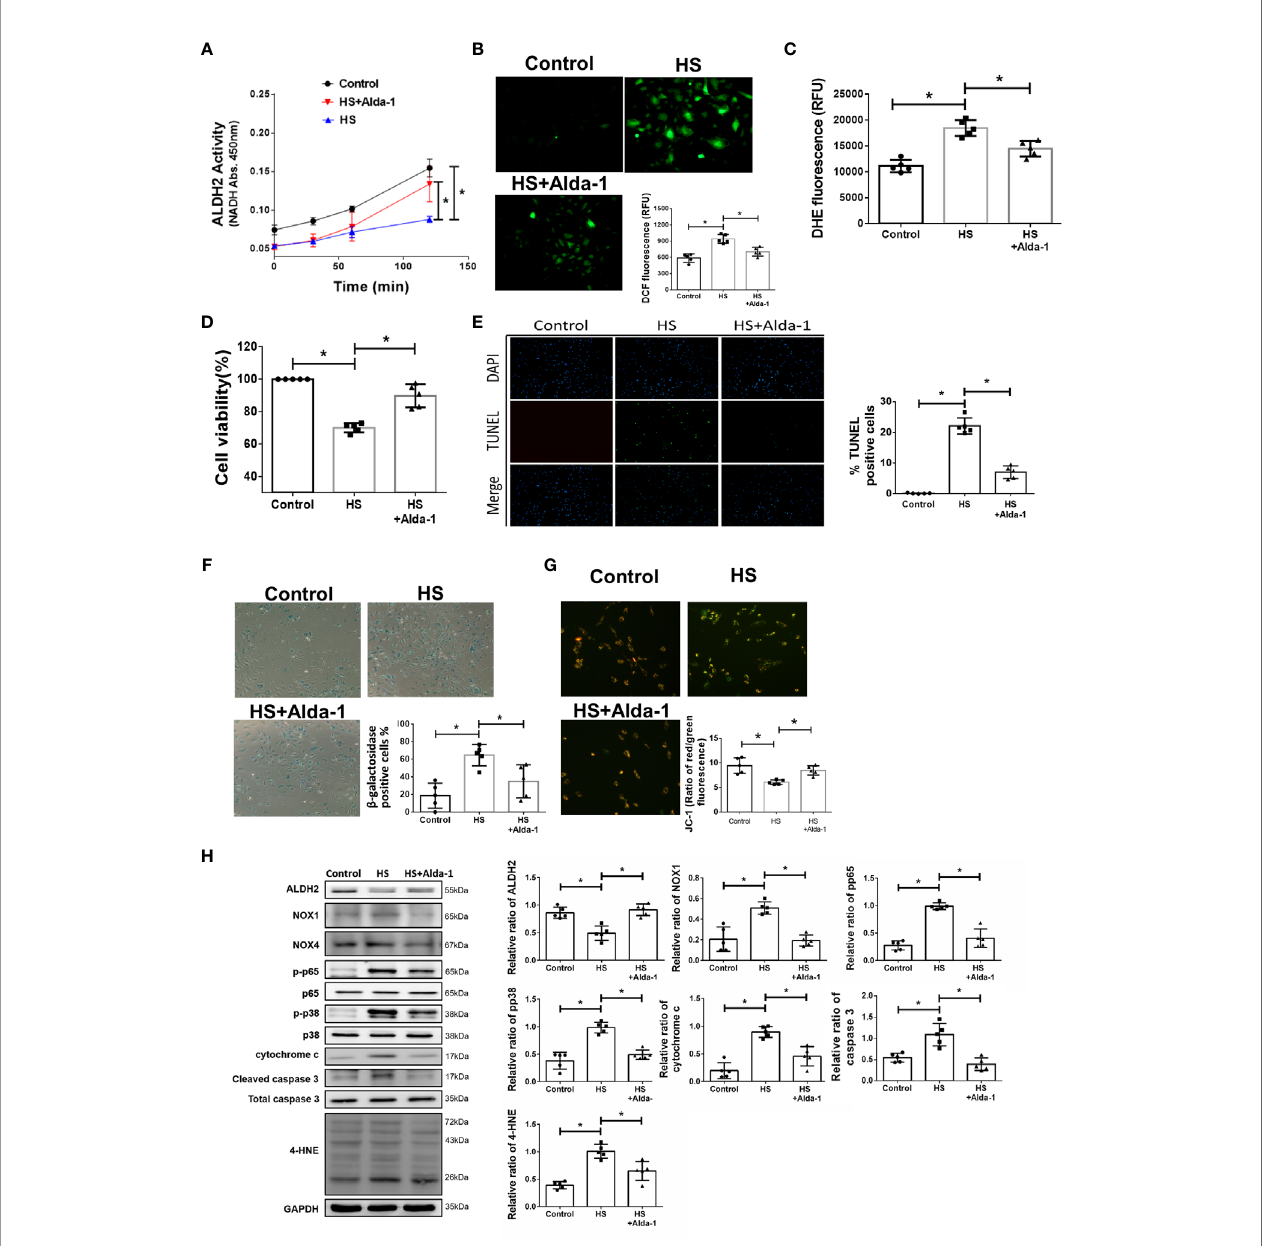
FIGURE 3 | Effects of Alda-1 on HS-induced vascular in fl ammation, ROS and apoptosis in vitro . Alda-1 (20 m M) was added to HUVECs for 6 h before HS (42°C for 2 h). (A) The ALDH2 activity in cell lysate was determined by measuring NADH production based on the O.D. absorbance at 450 nm in a microplate reader ( n = 5). (B) Measurement of ROS production based on DCF fl uorescence as determined by using a fl uorescence microplate reader with an excitation wavelength of 488 nm and an emission wavelength of 535 nm ( n = 5). (C) Measurement of cellular ROS production based on DHE fl uorescence as determined using a fl uorescence microplate reader with an excitation wavelength of 518 nm and an emission wavelength of 606 nm ( n = 5). (D) The viability of HUVECs was measured by the MTT assay based on the O.D. absorbance at 570 nm in a microplate reader ( n = 5). (E) The levels of apoptosis were measured by the TUNEL assay as determined by fl uorescence microscopy. The percentage of apoptotic cells was determined based on the number of TUNEL-positive cells among the total number of cells. (F) The levels of senescence were measured by b -galactosidase activity detection using bright fi eld microscopy ( n = 5). (G) Detection of mitochondrial dysfunction by the JC- 1 assay, revealing that the mitochondrial membrane potential ( DY m) was decreased in live cells as determined by fl uorescence microscopy and a fl uorescence microplate reader. The DY m level is expressed as the merge of the red and green channels, and the data were quanti fi ed as the ratio of red fl uorescence intensity to green fl uorescence intensity ( n = 5). (H) The protein and 4-HNE levels in lung homogenates were measured by immunoblotting. Densitometric analysis was conducted with imaging processing software. The data were quanti fi ed by normalization to GAPDH; phosphorylated proteins were normalized to total proteins ( n = 5). The data are expressed as the mean ± SD. Statistical signi fi cance is indicated as * p <